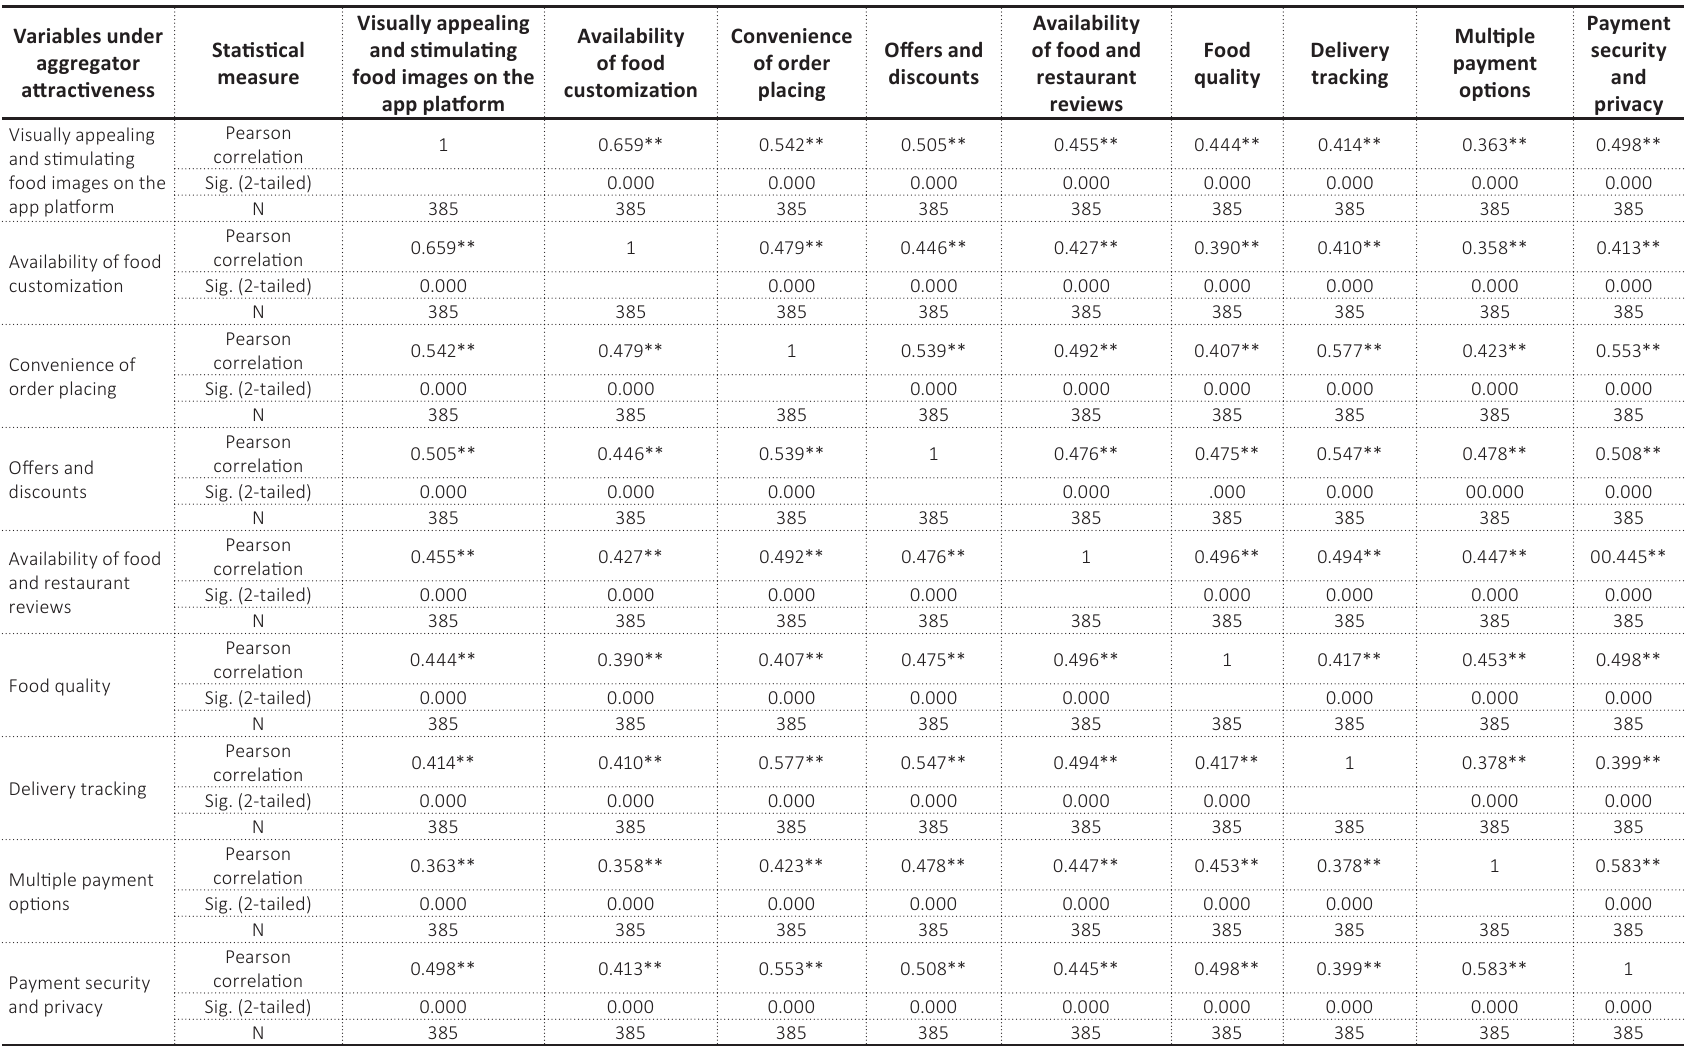
Table 1. Correlation of variables under aggregator